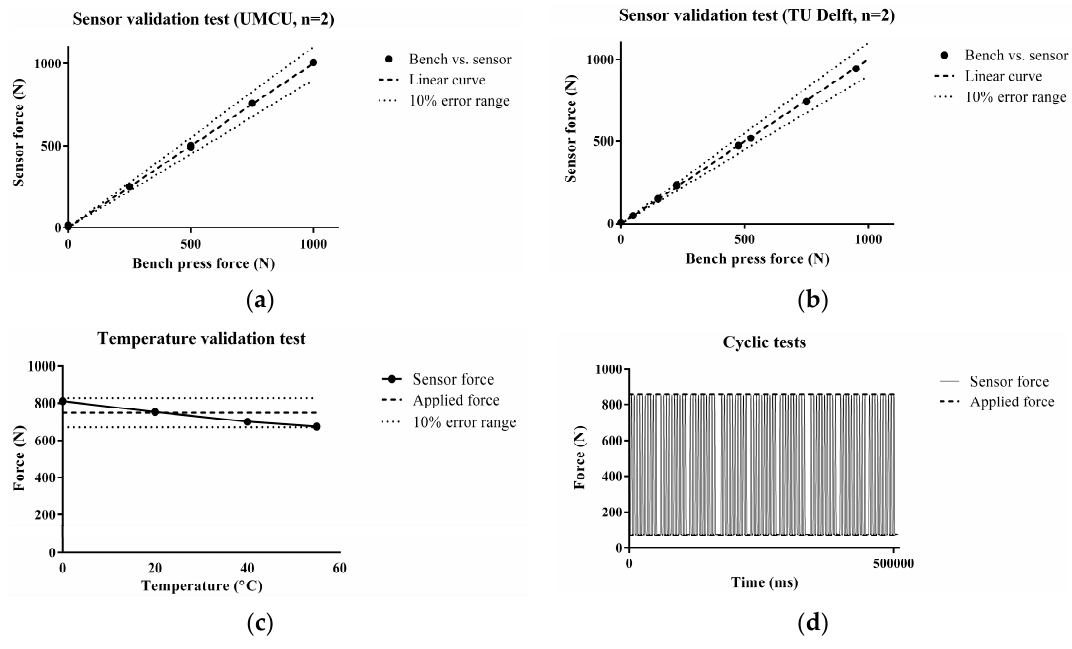
Figure 4. Validation of the sensor in the static situation. ( a,b ) Tests at the University Medical Center Utrecht (n = 2) and Technical University Delft (n = 2). The black dots indicate the applied force by the bench press versus the measured force by the sensor; ( c ) Sensor validation test at a broad range of temperatures (0–55 °C) at constant force (750 N). The black dots indicate the force measured by the sensor. The intermittent line represents the applied force by the bench press (750 N) with the 10% error range marked by dotted line. In the 20–37 °C range, the deviation was 1% at maximum. At extreme temperatures, the error fluctuates between +8% and − 9%, but remains within the range of 10%; ( d ) Cyclic loading at 20 °C. Cyclic fluctuating forces between 70 N and 860 N, highlighted by the intermittent line, were applied to the sensor. The error between applied force and measured force was negligible (<1%).